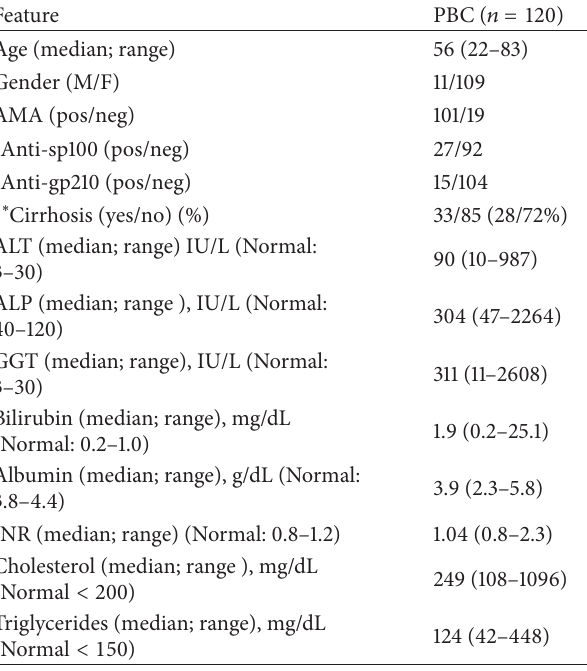
Table 1: Clinical and laboratory features of 120 patients with primary biliary cirrhosis (PBC) participated in the